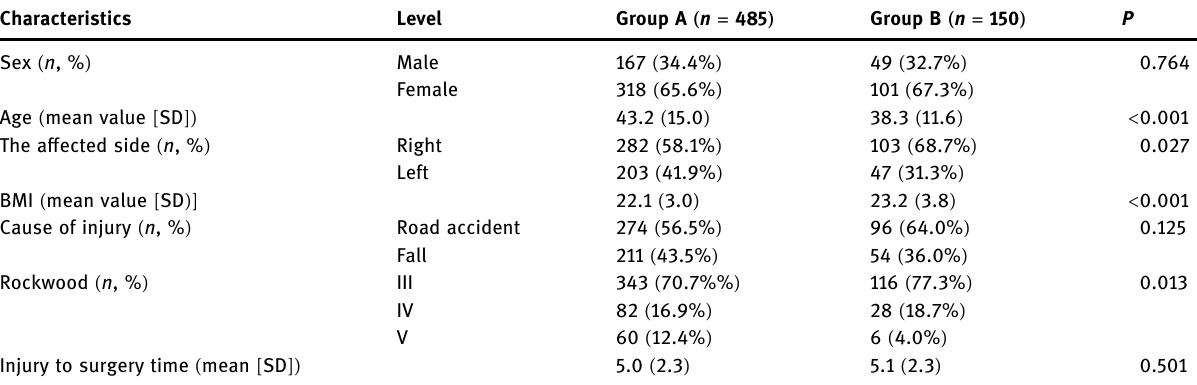
Table 1: Overall patient ’ s preoperative characteristics